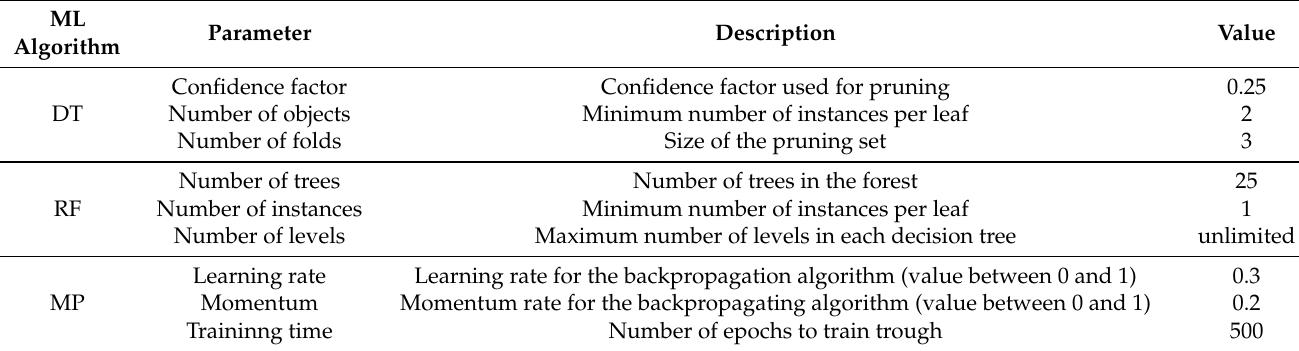
Table 1. Summary of the parameters used for DT, RF, and MP